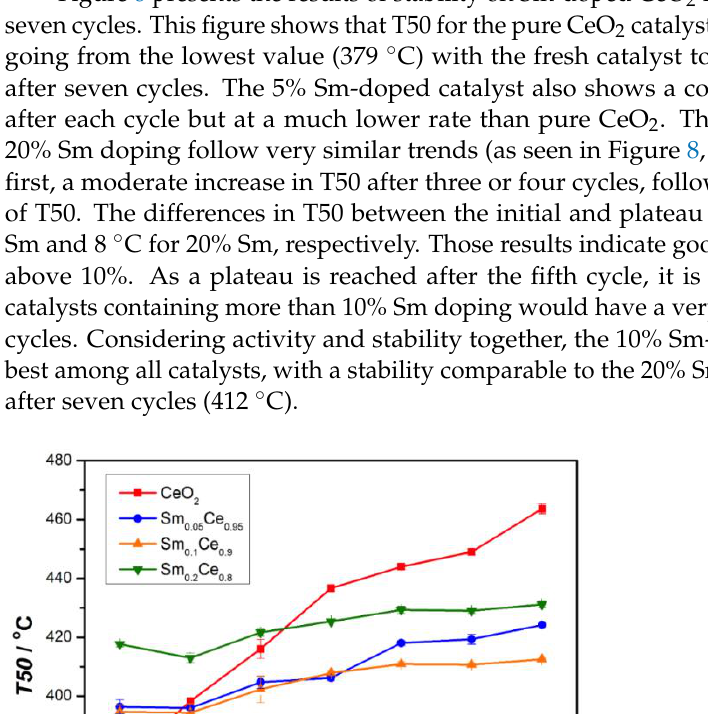
Figure 7. The relation between T50 and I 554 /I 596.